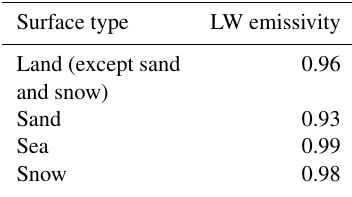
Table 1. Values of LW surface emissivity used for the LW atmo- spheric window in the radiative-transfer calculations.